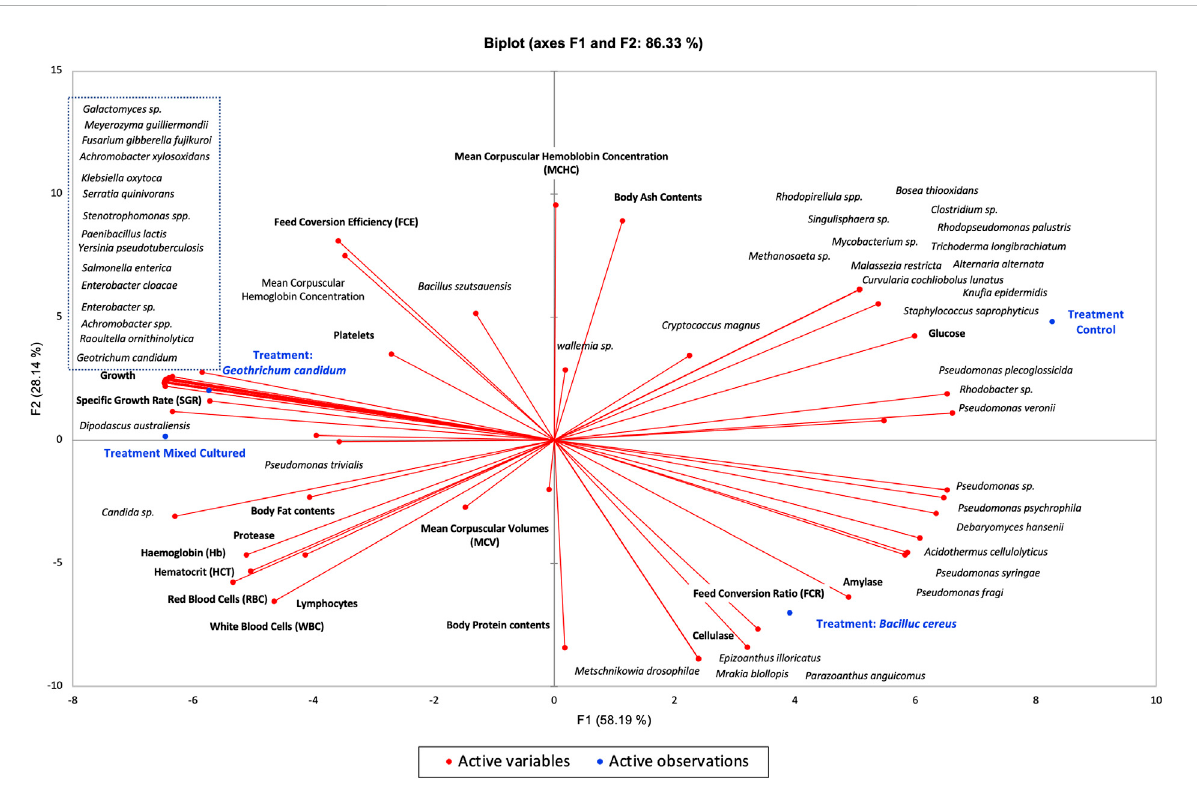
FIGURE 5 Bi-plot between growth, physiochemistry, hematology, intestinal enzymes and gut microbiota of all treatments Labeo rohita by using Principal component analysis